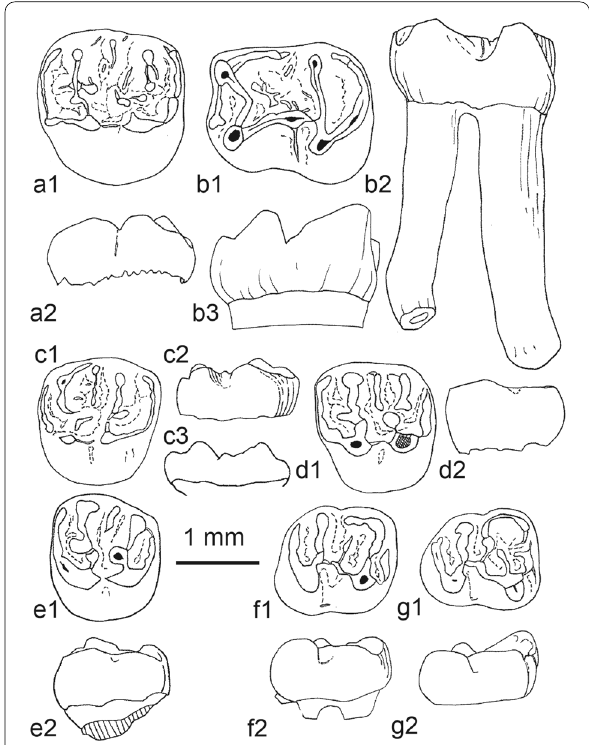
Fig. 53 Theridomyoidea gen. and sp. indet. a LAP 197, left M1; a1, occlusal view; a2, lingual aspect. b LAP 214, left m1; b1, occlusal view; b2, buccal aspect; b3, lingual aspect. Eoelfomys lapradensis nov. gen. nov. sp.. c : LAP 243, right M1, Holotype; c1, occlusal view; c2; lingual aspect; c3, buccal aspect. d LAP 245, left M1; d1, occlusal view; d2; lingual aspect. e LAP 244, left M2; e1, occlusal view; e2; lingual aspect. f LAP 242, right m2; f1, occlusal view; f2; buccal aspect. g LAP 241, right m3; g1, occlusal view; g2; buccal aspect. Scale bar: 1 mm